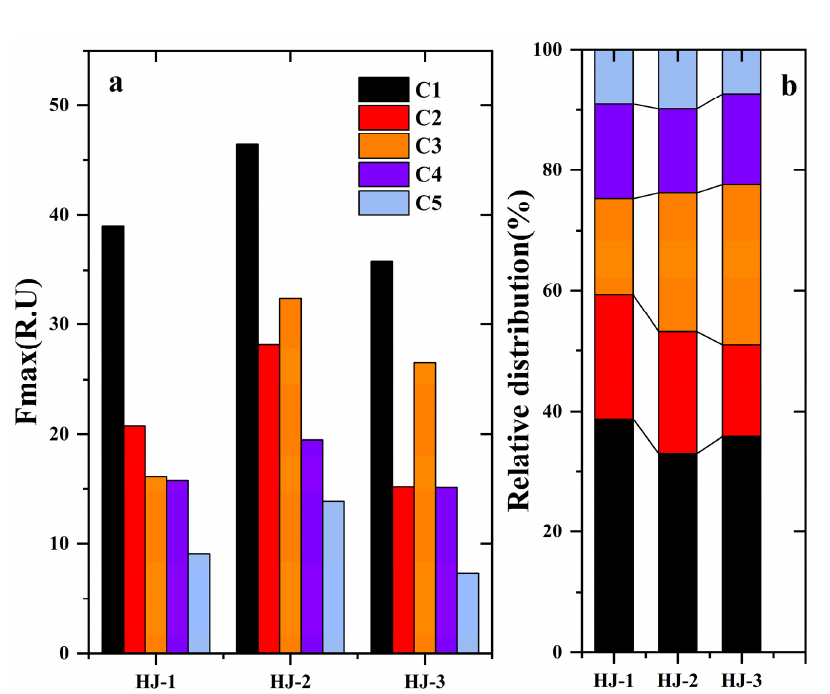
Figure 5. Intensity ( a ) and percentage ( b ) of fluorescence 5 components of DOM in fissured soils. Table 4. Types of DOM fl uorescent fractions in fi ssured soil.